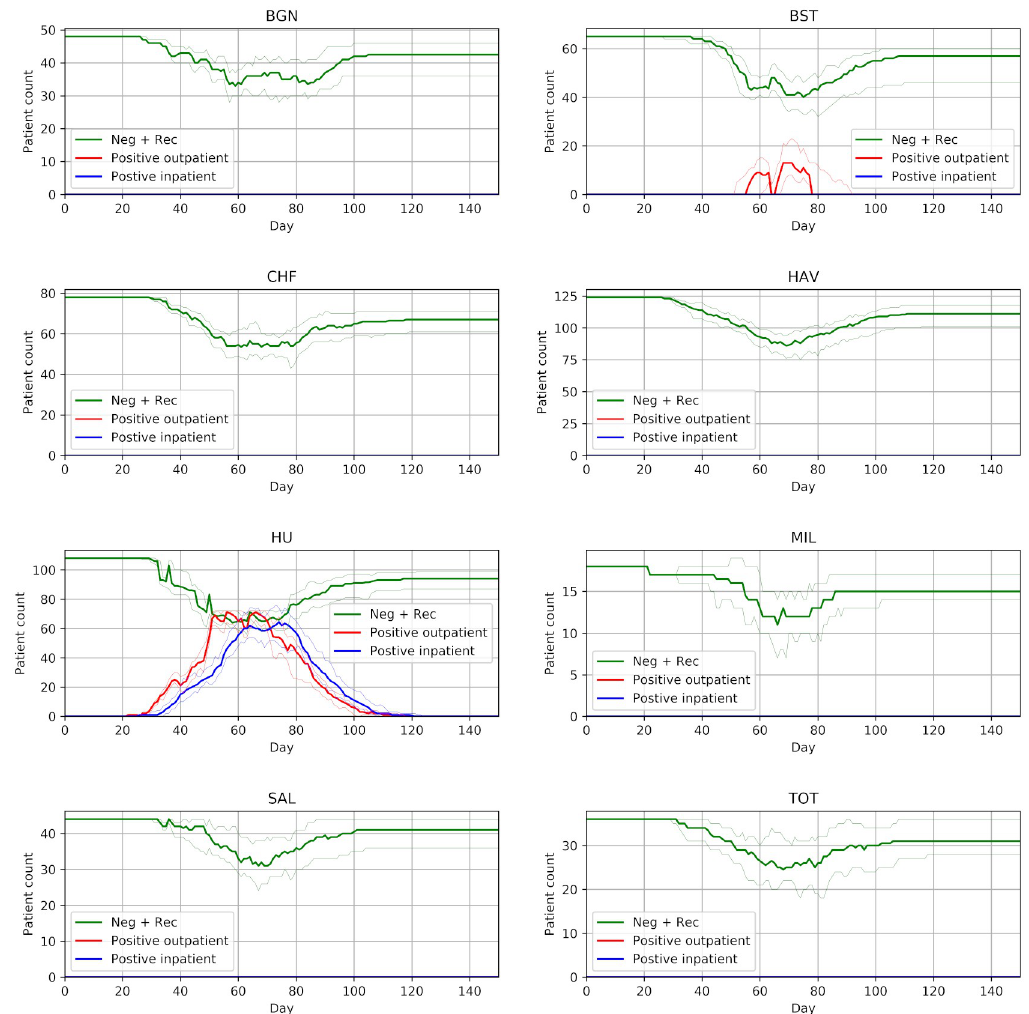
Fig 3. Progression of patient population through COVID infection, assuming 80% become infected over three months, with 15% mortality. The figure also shows the number of patients not allocated to a dialysis session at any time. The bold line shows the median results of 30 trials, and the fainter lines show the minimum and maximum from the 30